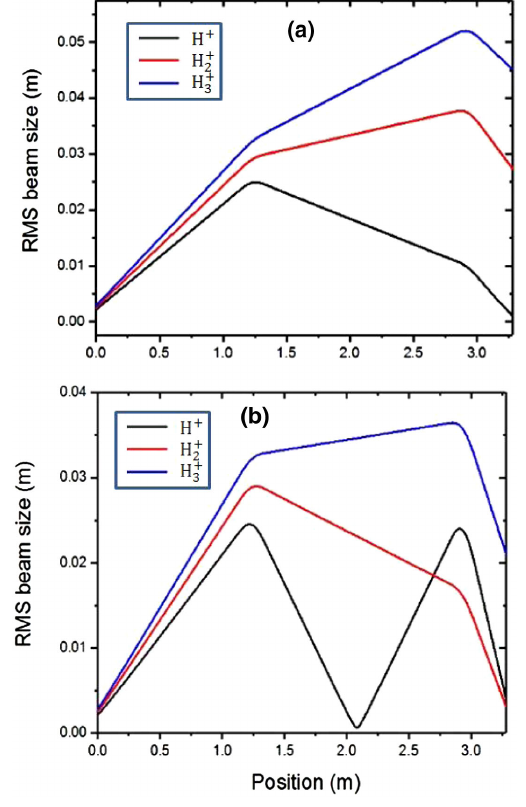
FIG. 5. Beam envelope for proton, H þ 2 and H þ 3 along the LEBT: (a) Scheme-I with gentle focusing and (b) Scheme-II with tighter